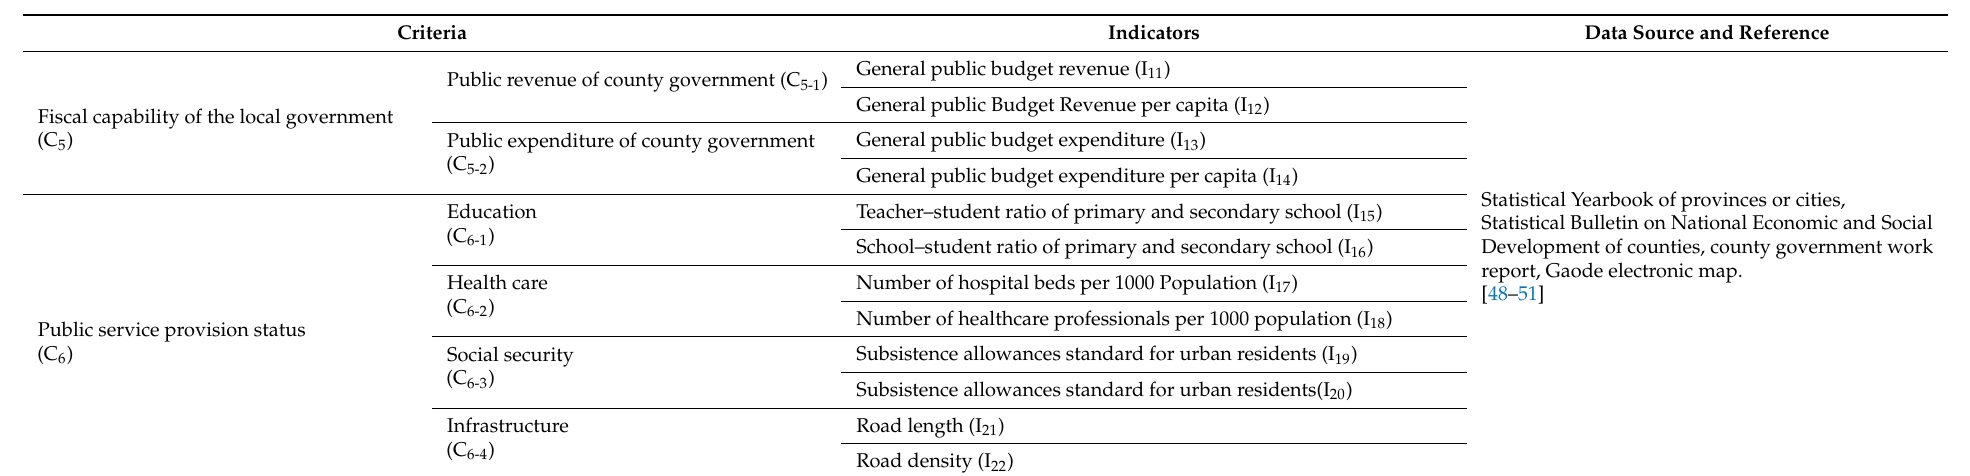
Table 3. Criteria and indicators for evaluating public service provision capacity